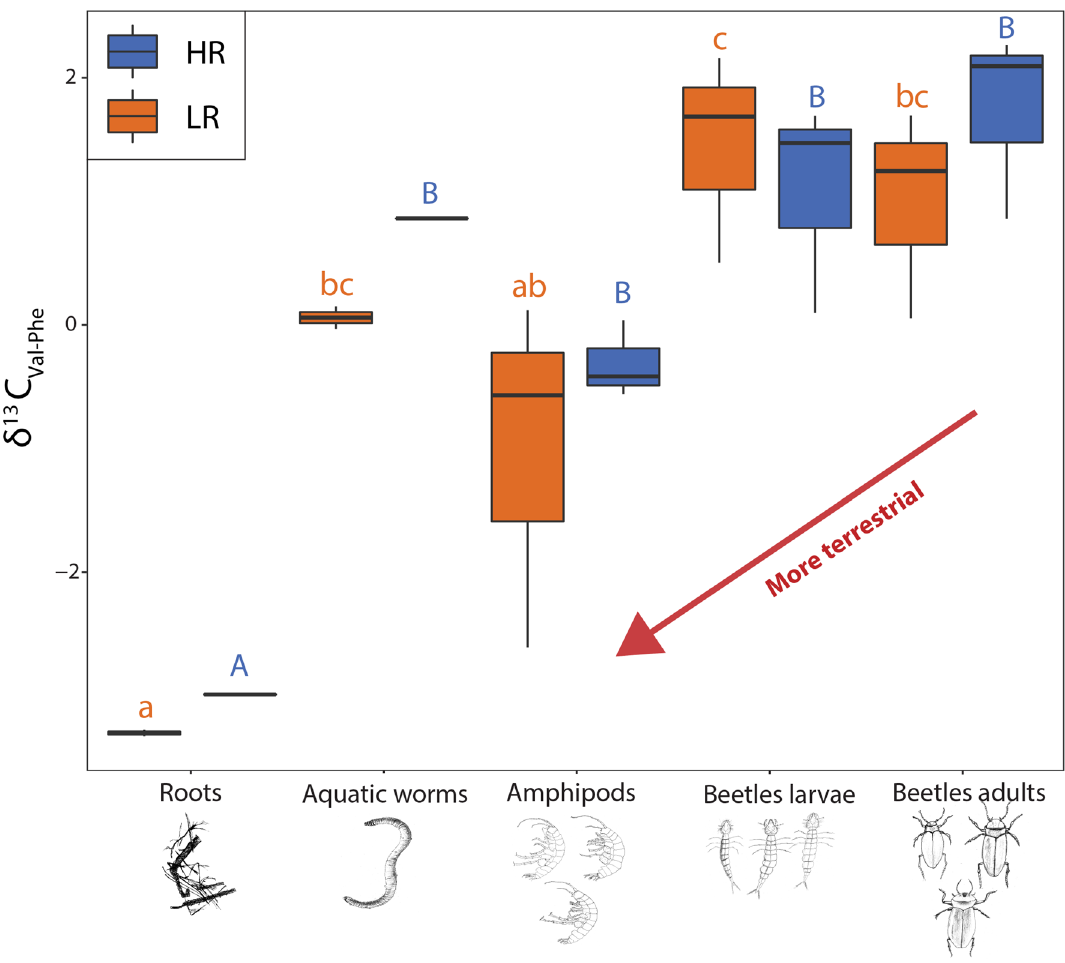
Figure 4. δ 13 C Phe-Val values calculated under LR and HR conditions for roots, aquatic worms, amphipods (AM1, AM2 and AM3), beetles larvae (Blv, Mlv, Slv) and adults (B, M, S). More negative values indicate a more terrestrial carbon source. Refer to Supplementary Table 2 and Supplementary Table 3 for the significances of the pairwise comparisons. Letters a,b and c are used to indicate significantly different δ 13 C Phe-Val values ( P < 0.05) for LR conditions, while letters A, B and C are for HR for the same purpose.